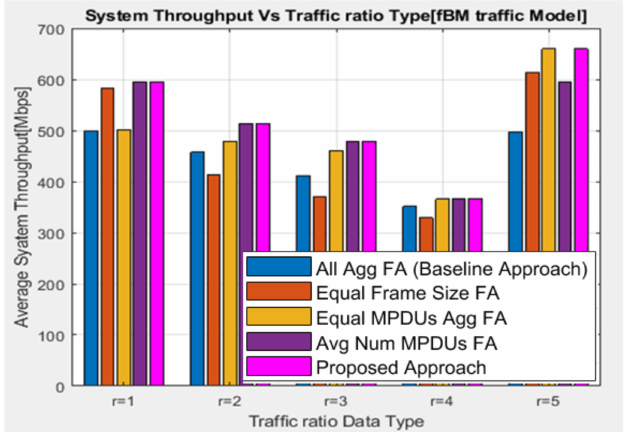
Figure 6. Performance of average system throughput under varying mixes of VoIP and video